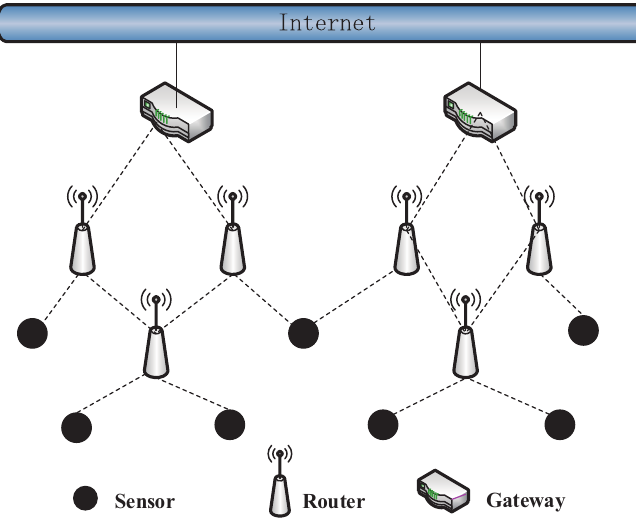
Figure 1. WMN gateway deployment using